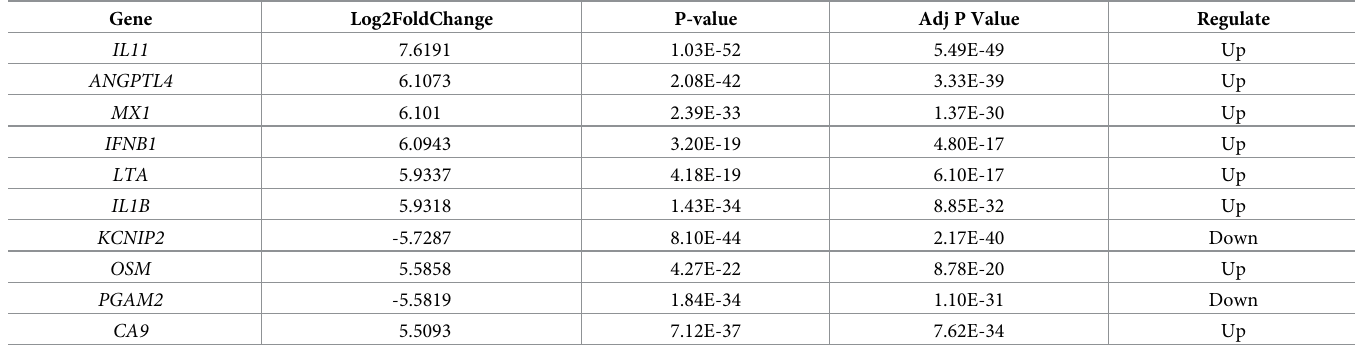
the 10 significant modules (Fig 3C), the lightcyan, turquoise (r = 0.15, p = 0.0019, Fig 3D), black, darkred modules were positively related to COVID-19 Myocarditis, whereas the green, brown, lightyellow, cyan, pink, and grey modules were negatively associated with COVID-19